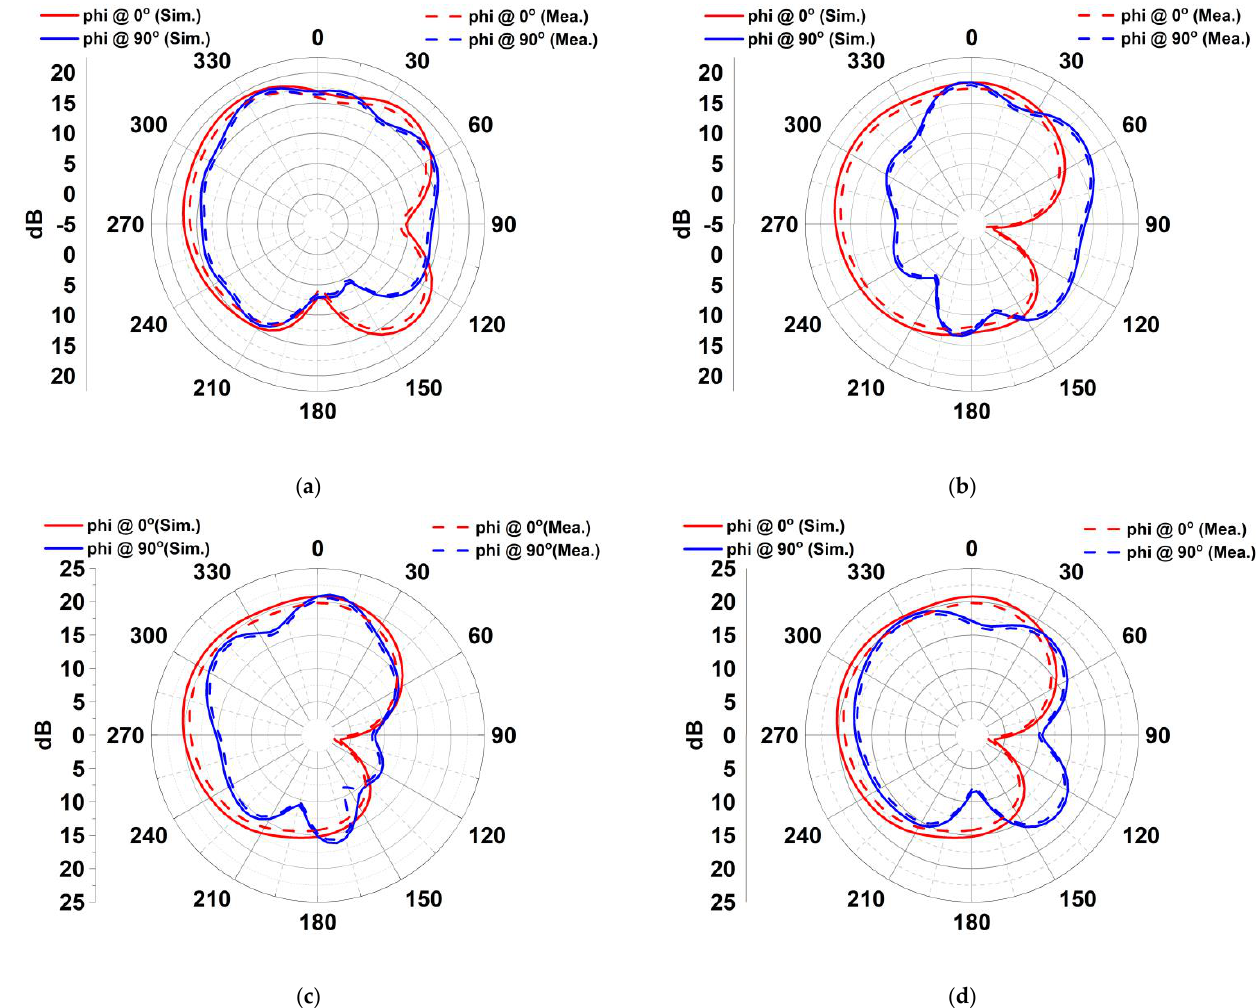
Figure 8. Simulated and measured radiation patterns of the MIMO antenna at 3.5 GHz ( a ) Ant 1 θ = 0° and 90° ( b ) Ant 2 θ = 0° and 90° ( c ) Ant 3 θ = 0° and 90° ( d ) Ant 4 θ = 0° and 90°.